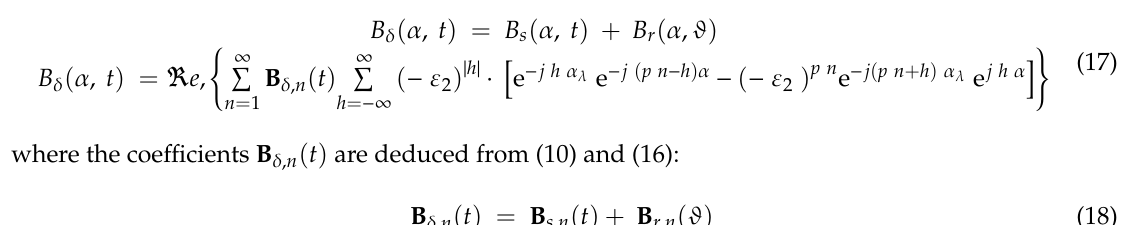
Table 1. Main motor parameters.